Question: What style of plot is this figure drawn as?
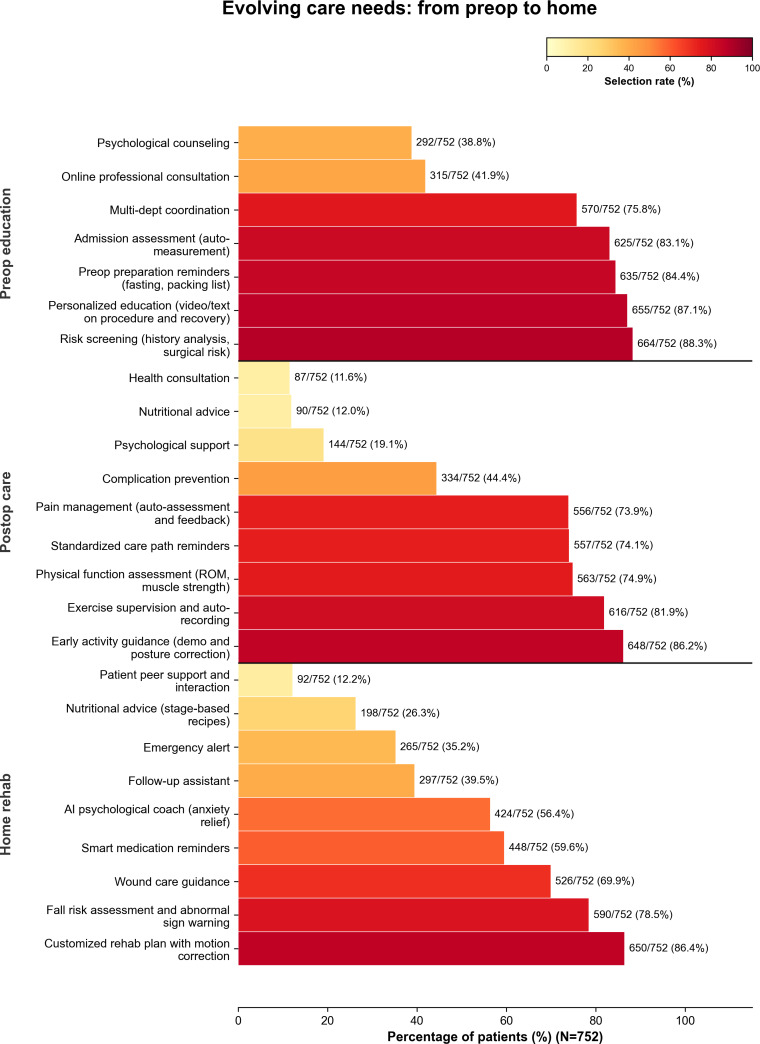
Answer: heatmap